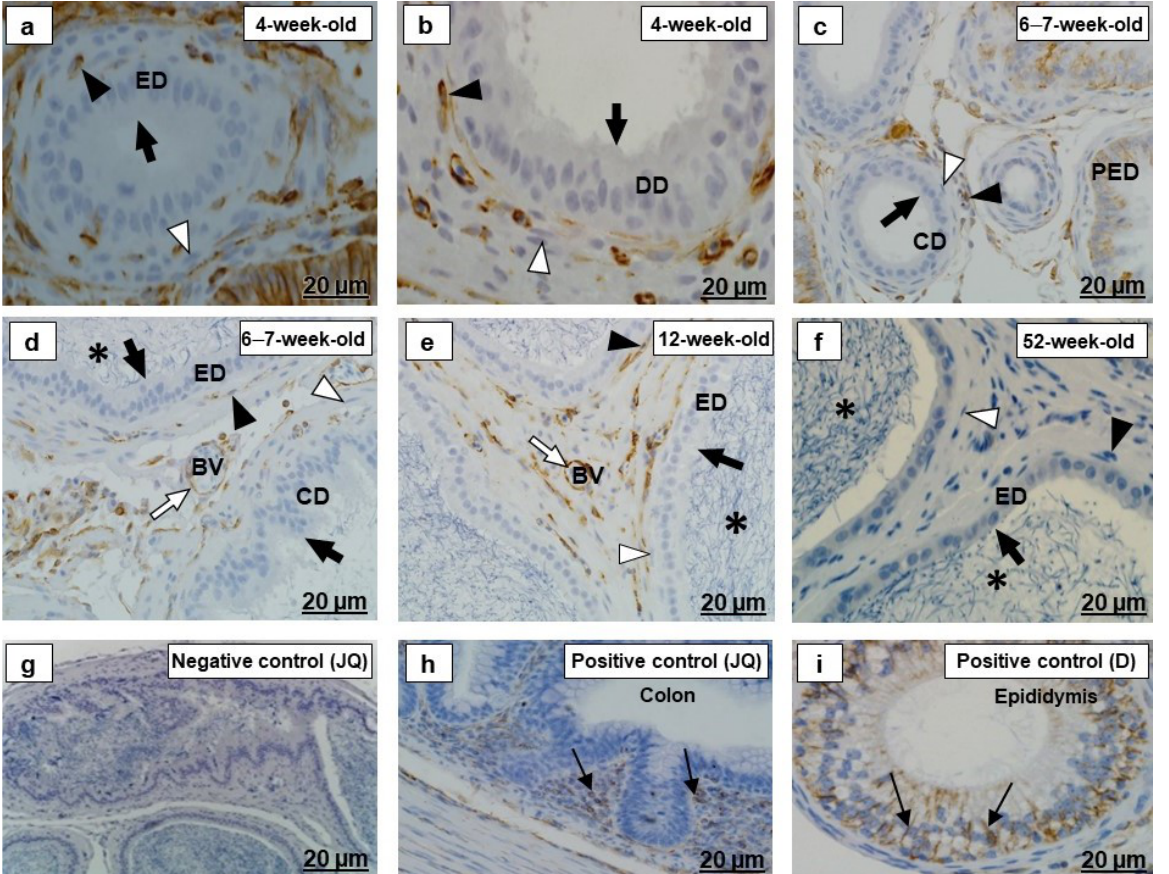
Figure 10. Immunolocalization of vimentin in the epididymal duct unit- (CD) connecting duct, (ED) epididymal duct and (DD) ductus deferens of the testicular excurrent duct system of Japanese quails ( n = 7 per age group). ( a – f ) Immunonegative epithelial- (black arrows) and smooth muscle cells (white arrowheads) of the CD, ED, and DD. ( a , b ) Black arrowheads indicate strong immunostaining in the fibroblasts. ( d , e ) Moderate immunostaining in the endothelial cells (white arrows) and fibroblasts (black arrowheads). ( f ) Immunonegative fibroblast (black arrowhead). ( d – f ) Immunonegative luminal spermatozoa (asterisks). ( g ) Negative control: Efferent ducts and epididymal duct of an adult Japanese quail. ( h , i ) Positive controls: Thin black arrows show immunopositive labeling in the lymphocytes in the submucosal layer of the colon of an adult Japanese quail ( h ) and epithelial cells of the dog epididymis ( i ). PED, Proximal efferent duct. BV, Blood vessel. D, Dog. JQ, Japanese